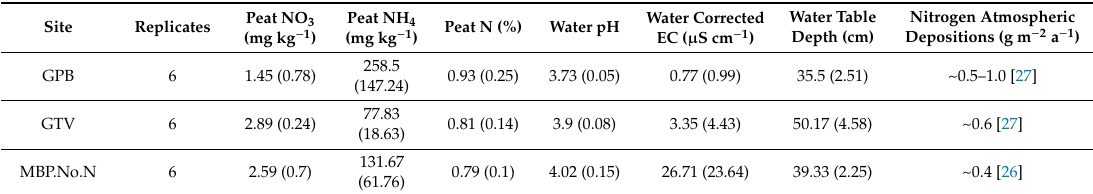
Table 2. Environmental properties measured along the environmental gradient. MBP: Mer Bleue, deposition only). EC: electrical